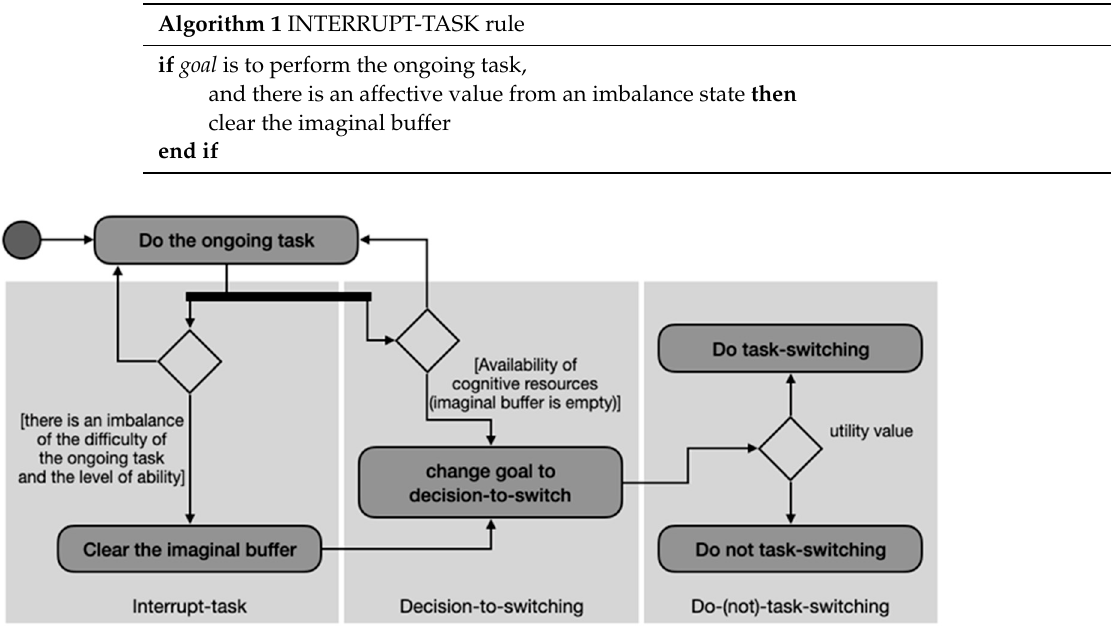
Figure 2. Symbolic structure of task switching.